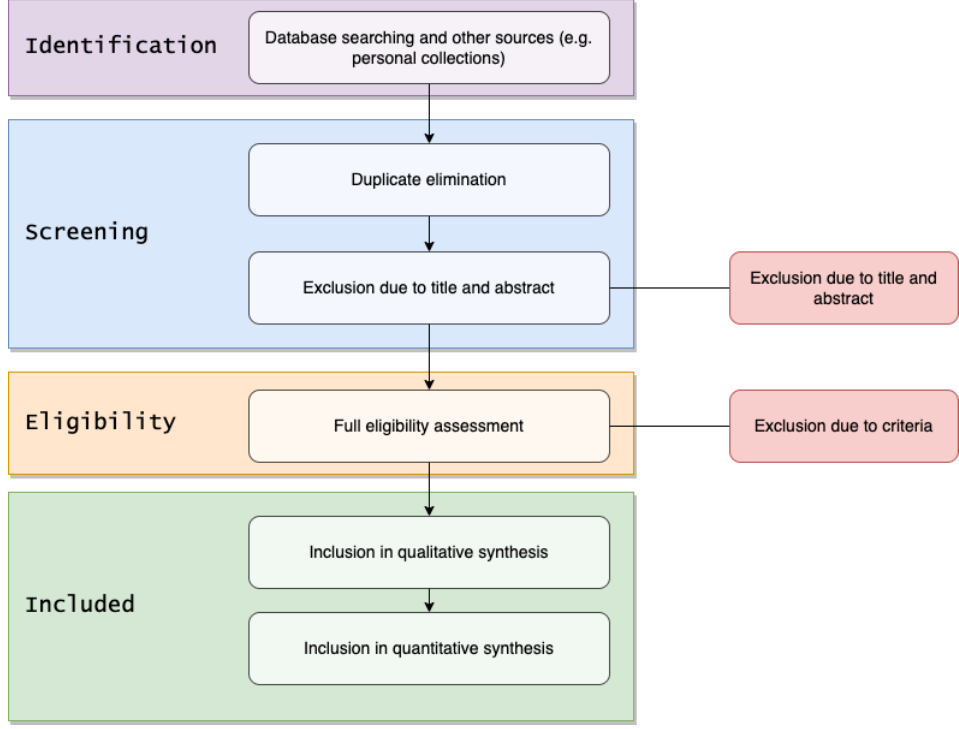
Figure 3. Research selection